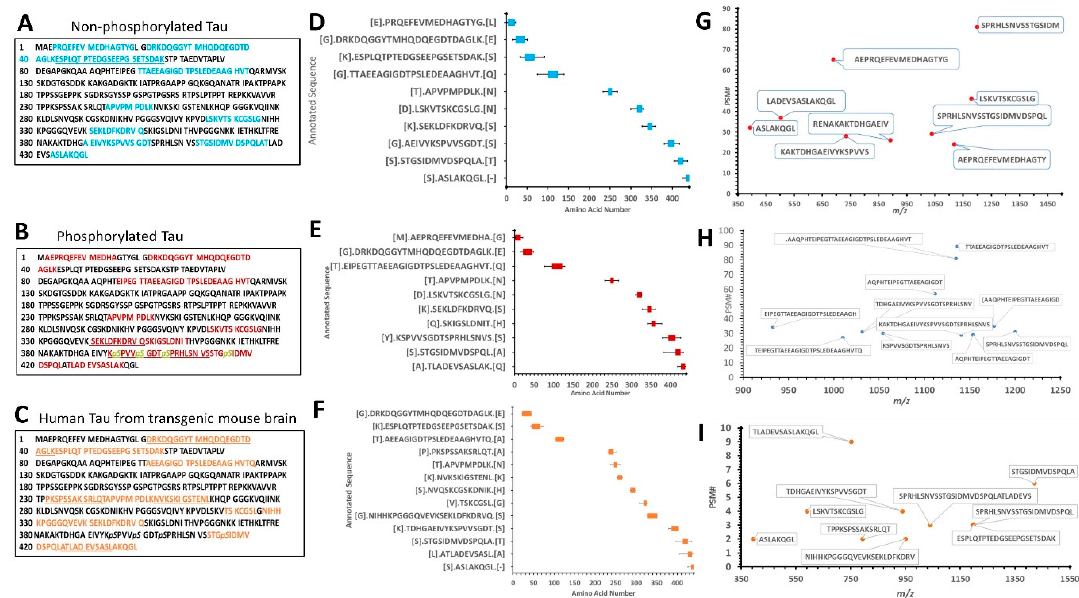
Figure 3. Characterization of low molecular weight calpain-mediated tau proteolytic peptides by mass spectrometry. A – C panels show tau (P10636-8) sequence with colored residues representing the peptides identified from recombinant tau, recombinant p-tau, and mouse brain lysate tau, respectively. The underlined residues represent the overlapping sequence between two proteolytic peptides. Amino acid residues in black color represent an unidentified sequence. D – F are schematic representations of tau, p-tau, and mouse brain htau peptides generated from calpain-1 digestion, respectively. The core peptides are shown in a colored rectangular box, while the variability of the different lengths of peptides is represented as error bars. These error bars were calculated from all biological replicates peptides that were high in confidence, XCorr value of 3, and minimum PSM value of 20 from Sequest HT search engine of proteome discoverer 2.2. Peptides found in control were omitted. Brackets on y-axis between letters represent adjacent amino acids that are not part of the original sequence but might be necessary for calpain cleavage. G – I are top-scored peptides based on peptide sequence matches (PSMs) from tau, p-tau, and mouse brain lysate samples, respectively. The y-axis represents the count number of each peptide, and x-axis represents mass over charge ratio ( m/z ) for non-phosphorylated-tau-441. For each selected peptide, at least 20 PSM and an XCorr value of 3 was used from proteome discoverer 2.2 software to present high confidence identifications. For brain Lysate filtrate fractions, we have identified two clusters of N-terminal, the middle region, and C-terminal domain peptides with a fragmentation pattern that is again closely similar to the recombinant purified tau-441 calpain-mediated proteolysis pattern (Table 3; Figure 3C,F,I). The PSM around the region a.a.:413–441 of brain lysate considerably overlapped with the purified tau protein coverage (Figure 3D–F), suggesting that calpain-1 digested the cellular htau similar to purified htau protein. However, the mid-region (a.a. 225–300) of brain lysate showed a different fragmentation pattern of tau (Figure 3F). Figure 3G–I summarize the top 10 highest peptide sequence matches (PSM) scores of calpain-mediated tau proteolytic peptides from recombinant tau and brain lysate source. The PSM number represent the times the Mass spectrometric instrument detected the fragments based on the data-dependent acquisition. The purified recombinant tau samples had more peptides counts (80–100 peptides) compared to the mouse brain sample (10 peptides) (Figure 3G–I). A possible explanation is that calpain can proteolyze other proteins as a substrate in a brain sample decreasing its potency to tau compared to the samples that have tau only. A well-known approach for monitoring peptide abundance for peptidomics studies is implementing the use of peak intensity. Peak intensity involves the calculation of the ion current of the peptide as it elutes from LC/MS usually integrating signal over the entire elution period,